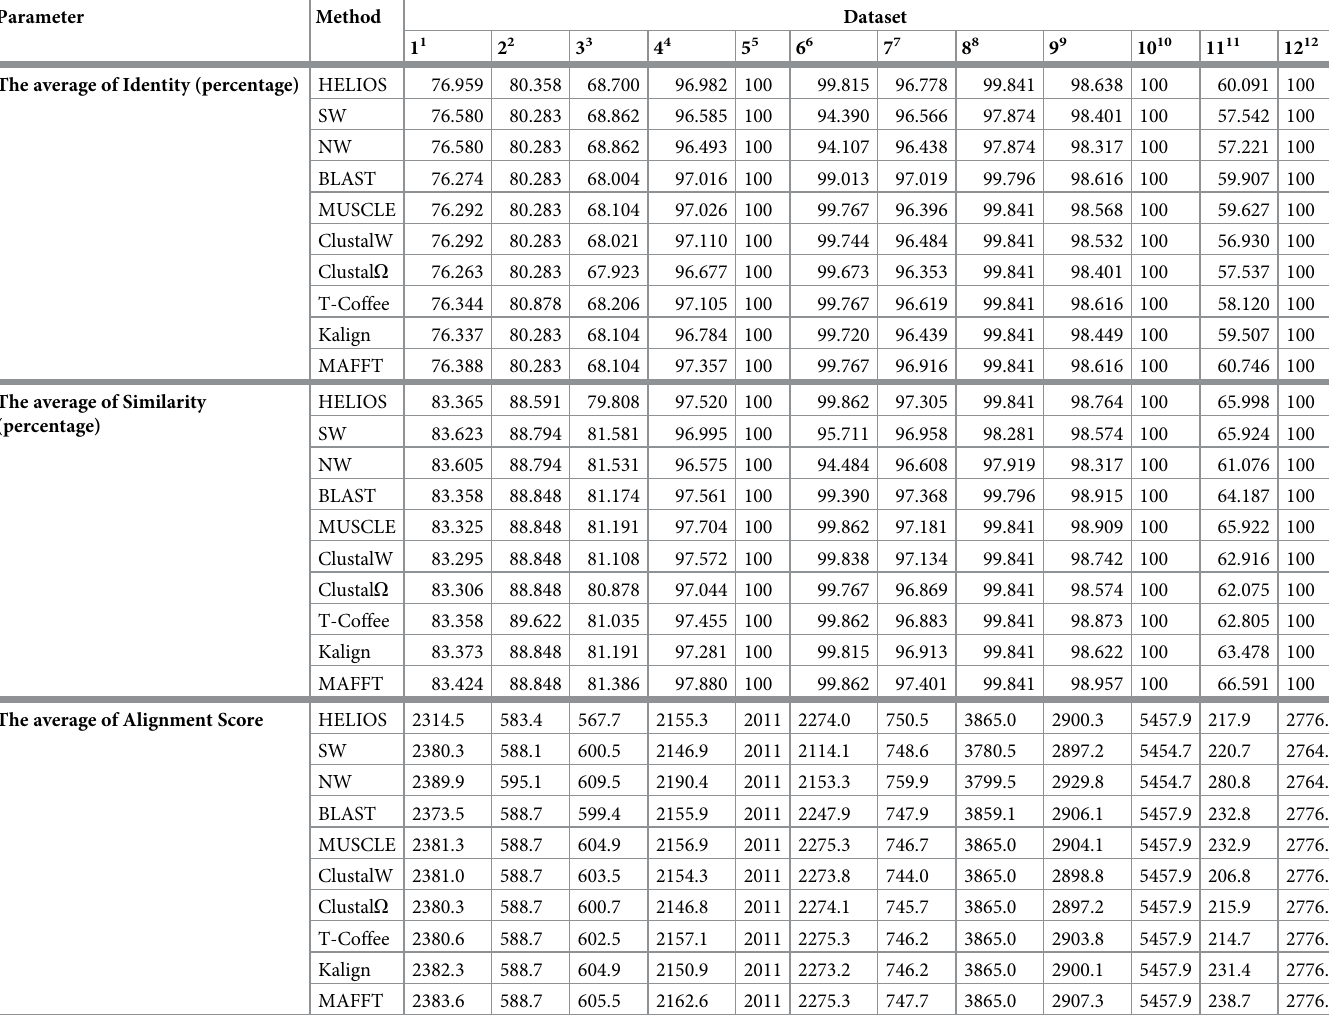
Table 7. A brief report of the quantitative measurement of homology of measurement of the HELIOS method, compared to nine well-known algorithms, including SW, NW, BLAST, ClustalW, Clustal O , Muscle, T-Coffee, Kalign, and MAFFT. In this manner, the parameters Identity, Similarity, and Alignment Score are reported. The Identity reports the number of exactly matched characters of two compared sequences (in percentage), aligned by each algorithm. Moreover, the Similarity measures the resemblance of two compared sequences (in percentage), aligned by every aformentioned algorithm. Various amino acids are categorized into six groups based on their physicochemical properties; including GAVLI, FYW, STCM, KRH, DENQ, and P. Finally, to calculate the Alignment Score of two compared sequences, aligned by every aforementioned algorithm, the BLOSUM62 substitution scoring matrix is adopted with gap opening and extension penalties equal to -10 and -0.5, respec- tively. Twelve diferent datasets are considered for this study [53,